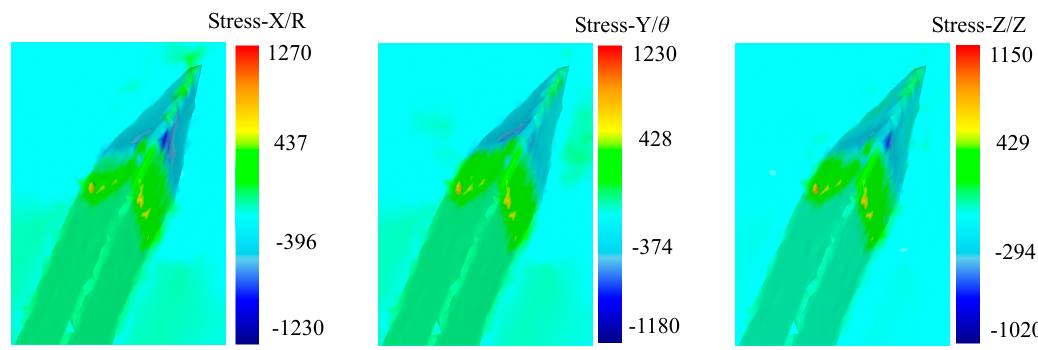
Figure 11. Tri-axial stress distribution in the process.